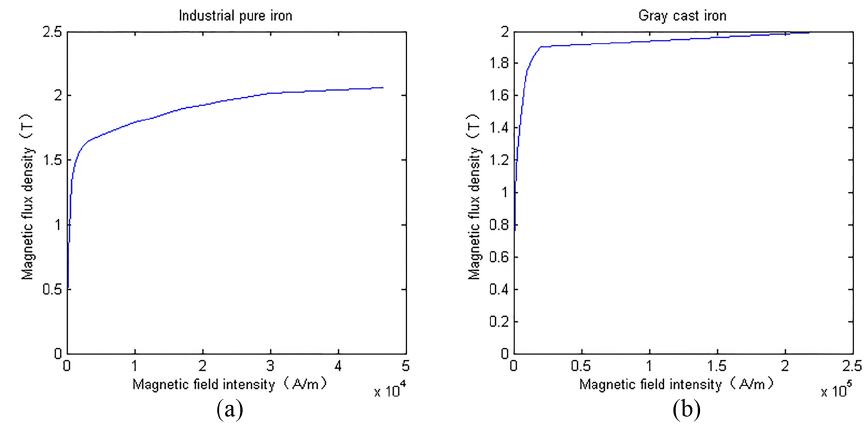
Figure 2. Magnetization curves of soft magnetic